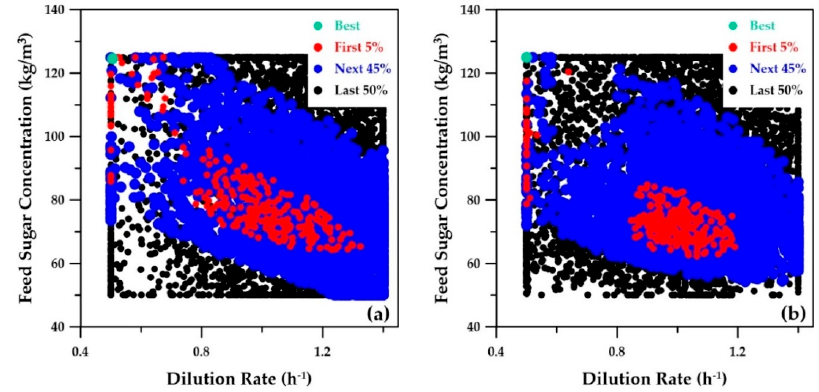
Figure 10. Plots of the numbers of membrane modules versus butanol productivity for the integrated fermentation–membrane pervaporation system: ( a ) ANN metamodels; ( b ) actual integrated system simulation.